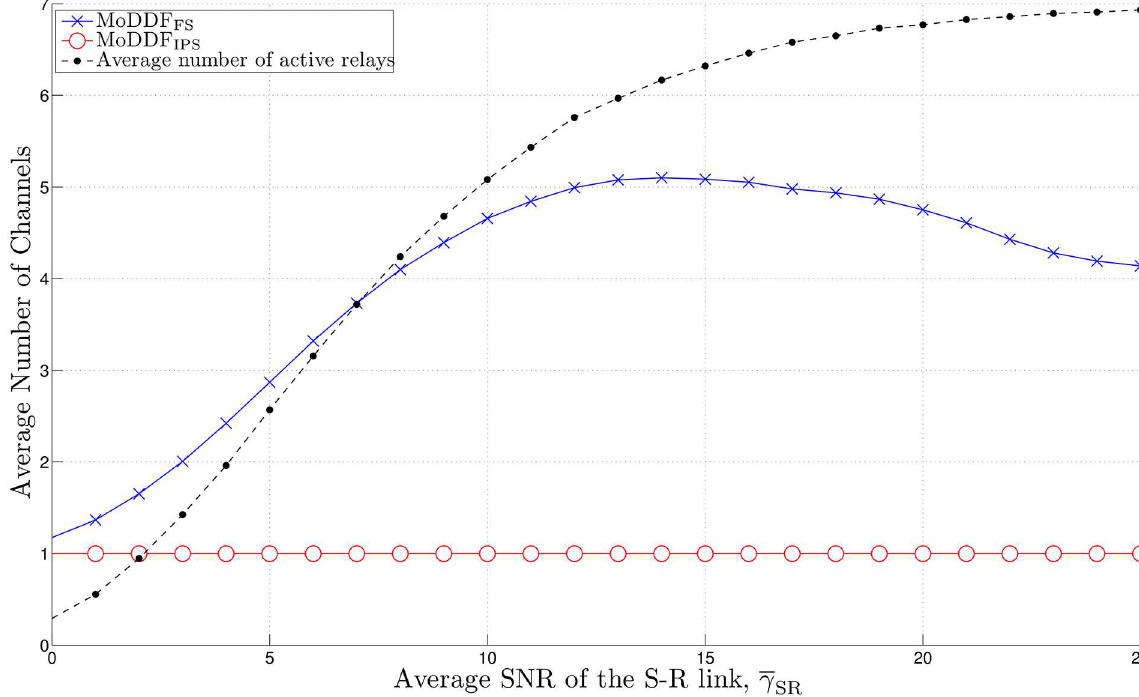
Fig 7. Maximum channel usage per single subframe when M = 7, N = 15, and R th =